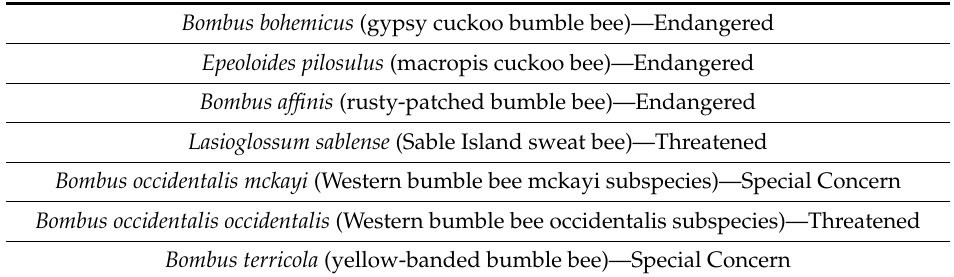
Table 1. The seven species of native bees that are endangered or of concern in Canada as of February, 2019. Bombus bohemicus (gypsy cuckoo bumble bee)—Endangered Epeoloides pilosulus (macropis cuckoo